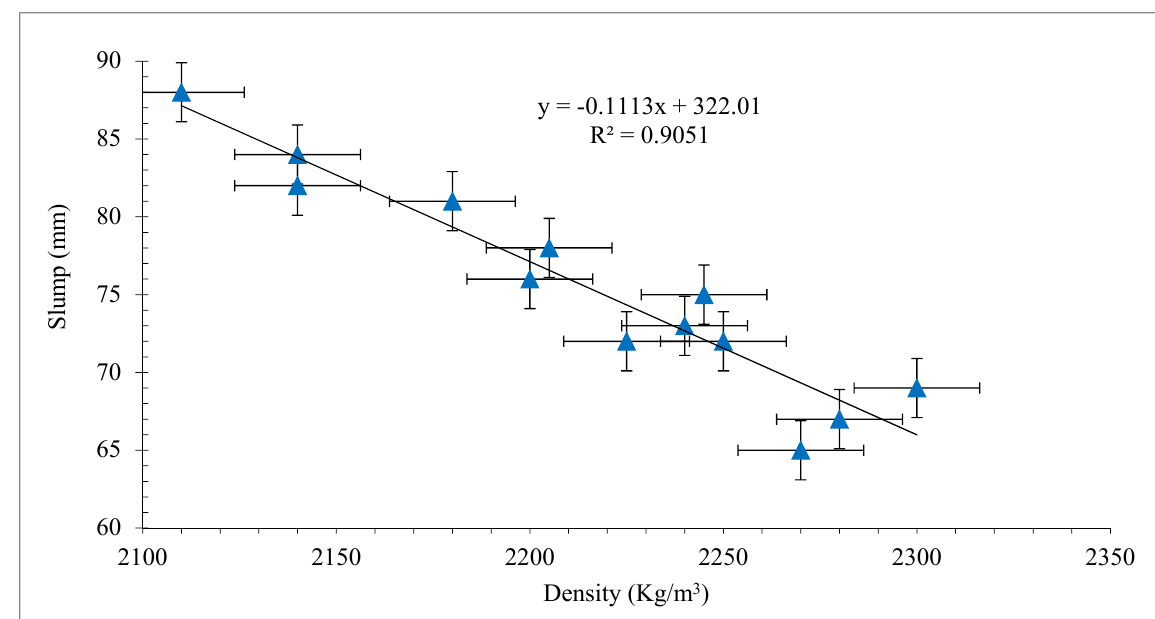
Figure 3. Correlation between slump and fresh density with coconut fibers.